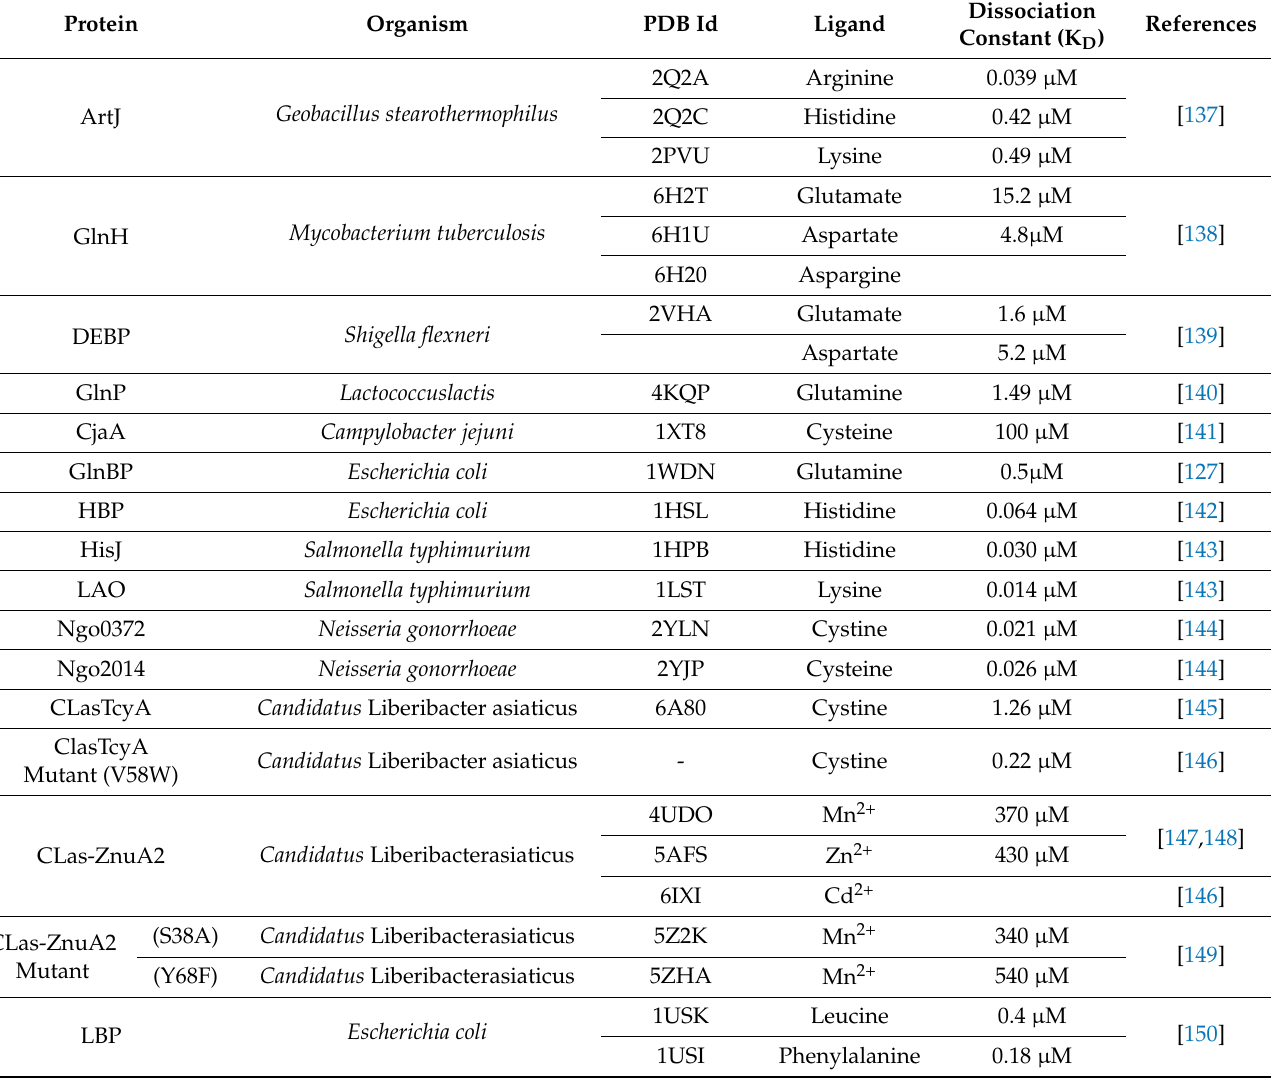
Table 3. Binding studies of a solute-binding protein from different bacteria.